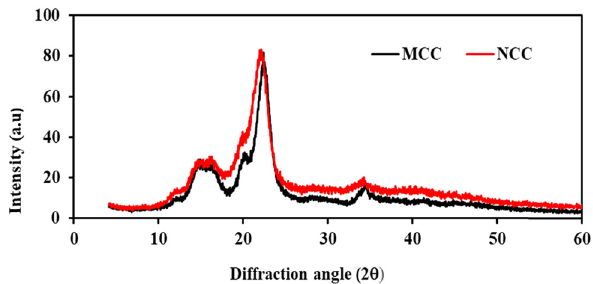
Figure 6: X - ray di ff ractograms of MCC and NCC from pineapple